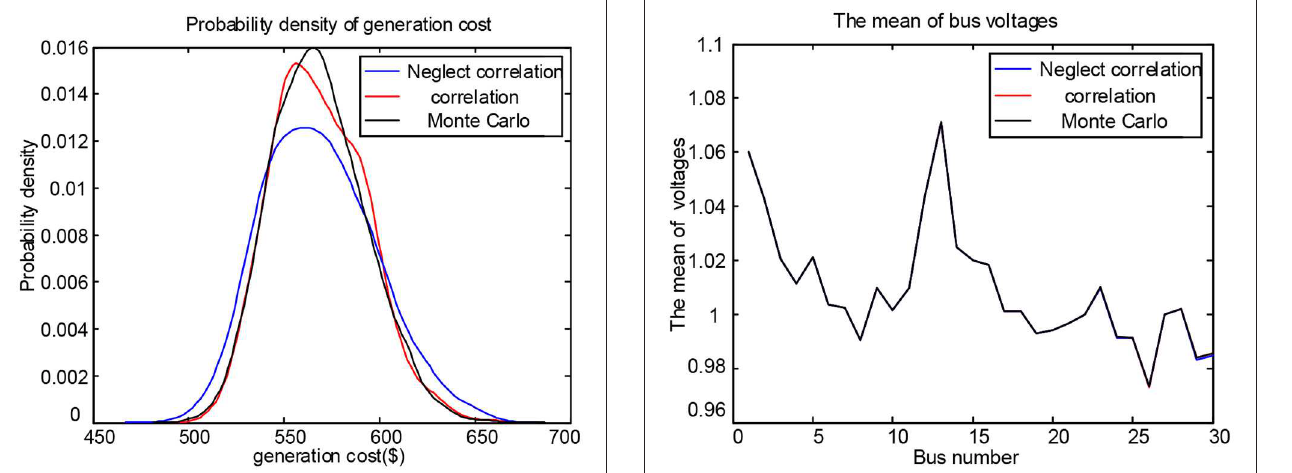
FIGURE 9 | Probability density of generation cost.